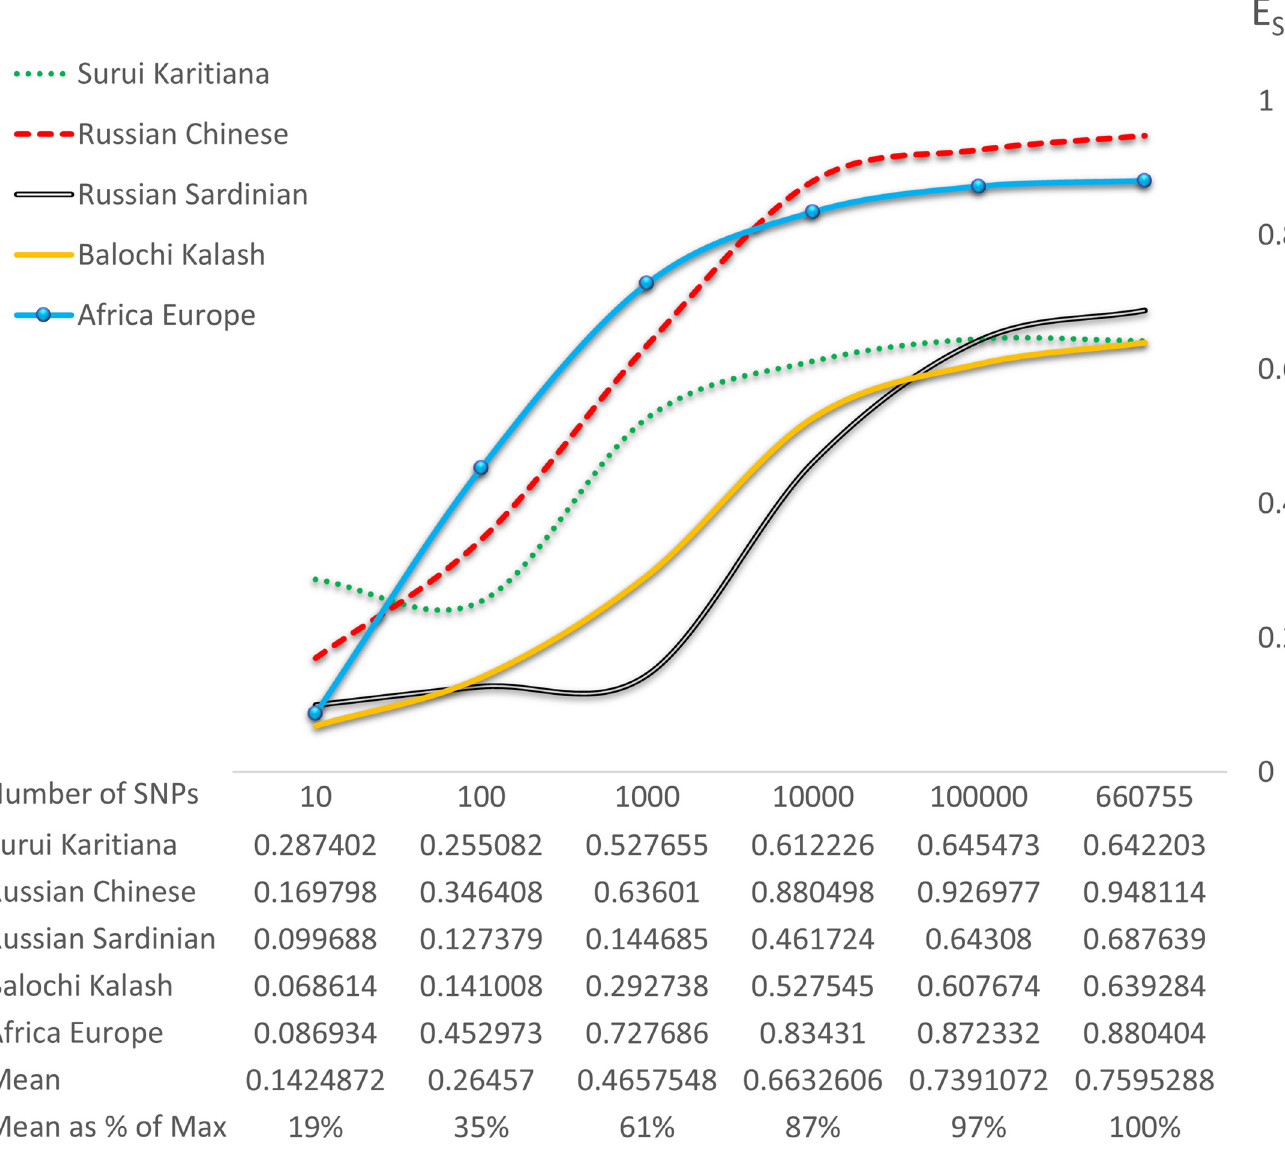
Fig 3. E ST as a function of SNP sample size. E ST was estimated in various population pairs with gradually increasing SNP sample size from 10 to 660,755. As expected, E ST initially rises rather steeply, but tends to plateau before reaching the 660,755 SNP point. This suggests that we are approaching the maximal resolving power of genetic markers in this dataset, and adding markers beyond this point should not have a significant effect on -cluster separation and E ST